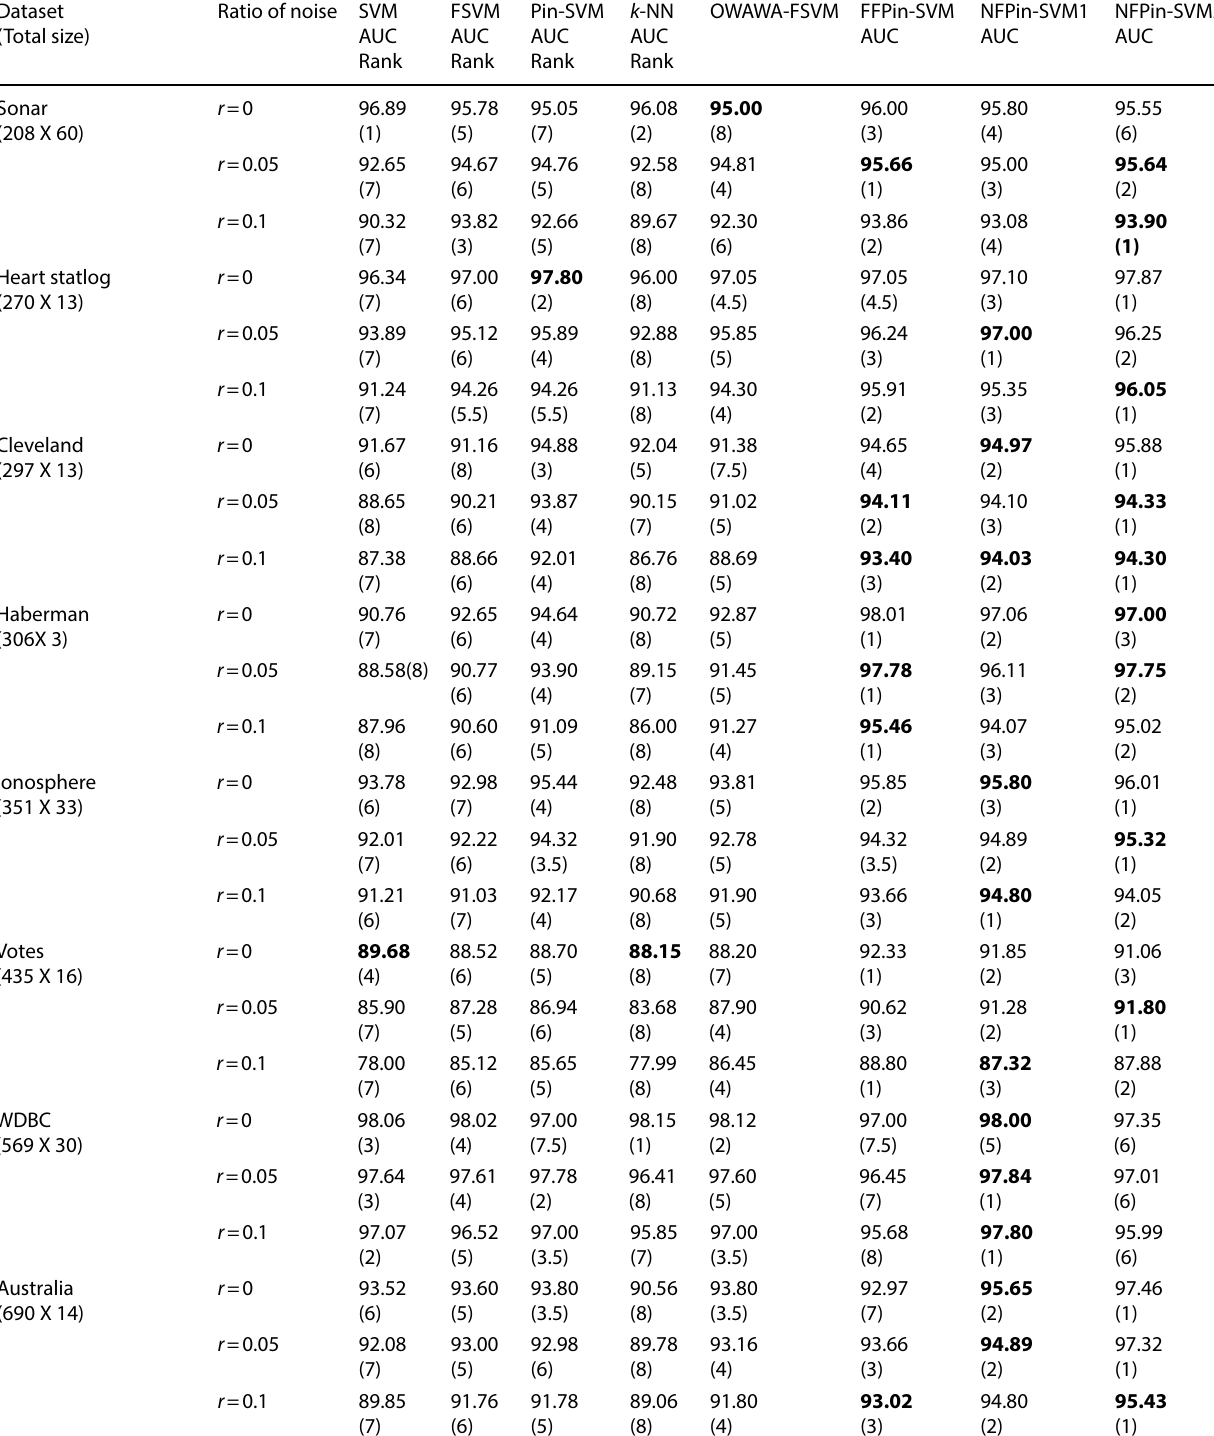
Table 5 The AUC as performance comparison of our proposed methods of nonlinear FPin-SVM, NPin-SVM, and SPin-SVM with nonlinear Pin- SVM, FSVM, k -NN, OWAWA-FSVM, and SVM in the Real world with different noises Dataset (Total